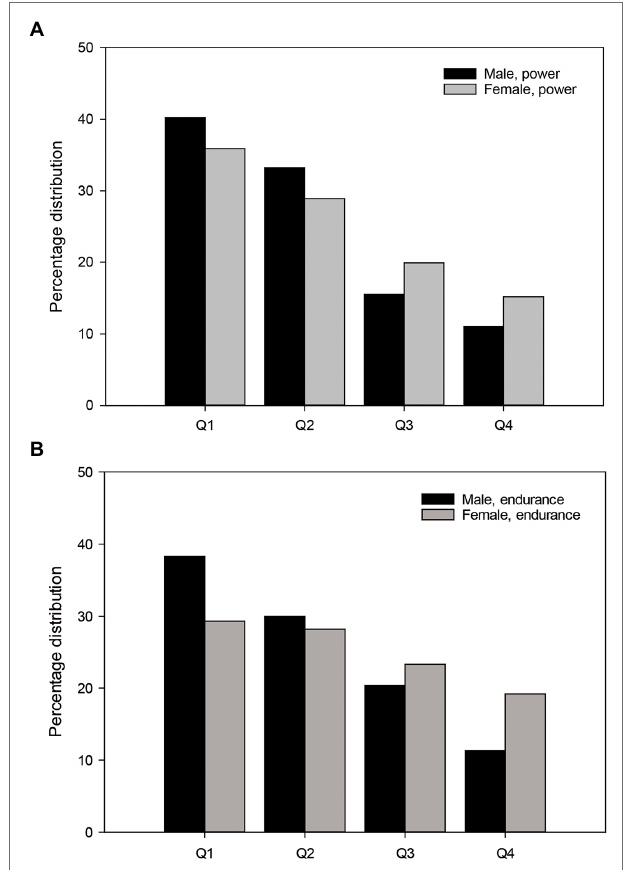
FIGURE 2 | Percentage quarterly birth distribution for males and females in the power events (A) and endurance events (B) . Q1 = Jan-March, Q2 = April– June, Q3 = July–Sept, Q4 = Oct–Dec. Number of subjects decreases significantly from Q1 to Q4 for both males ( ɸ = 0.46, p < 0.05, Large RAE and ɸ = 0.38, p < 0.05, Medium RAE) and females ( ɸ = 0.30, Medium RAE, p < 0.05 and ɸ = 0.13, p < 0.05, Small RAE) in power and endurance events,